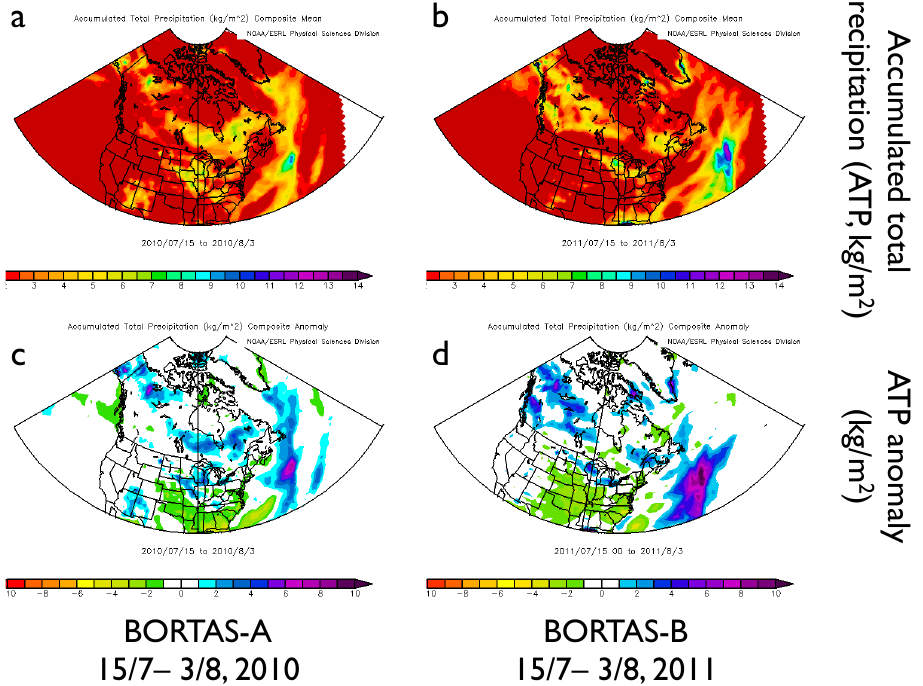
Fig. 4. Daily mean accumulated precipitation (kgm − 2 ) over North America for 15 July–3 August, 2010 (a) and 2011 (b) , and the associated anomalies for 2010 (c) and 2011 (d) with respect to the 1981-2010 climatological mean. Image provided by the NOAA/ESRL Physical Science Division, Boulder, Colorado